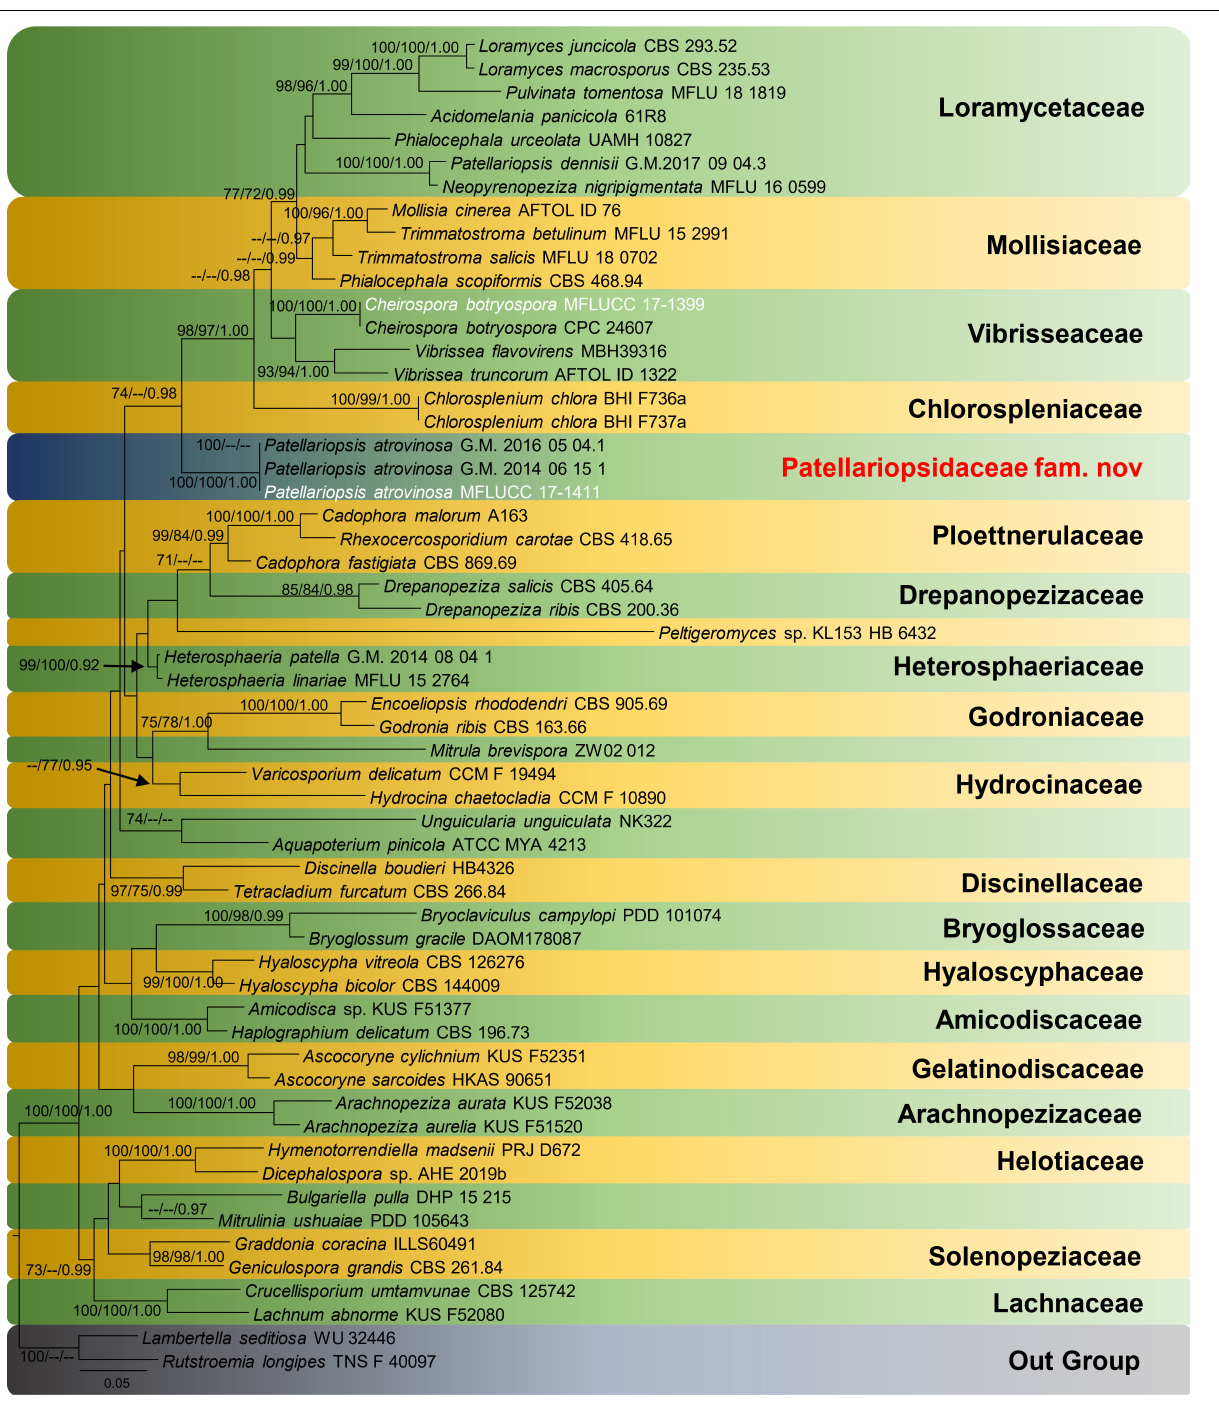
Sporodochium 33–37 µ m high, 278–355 µ m